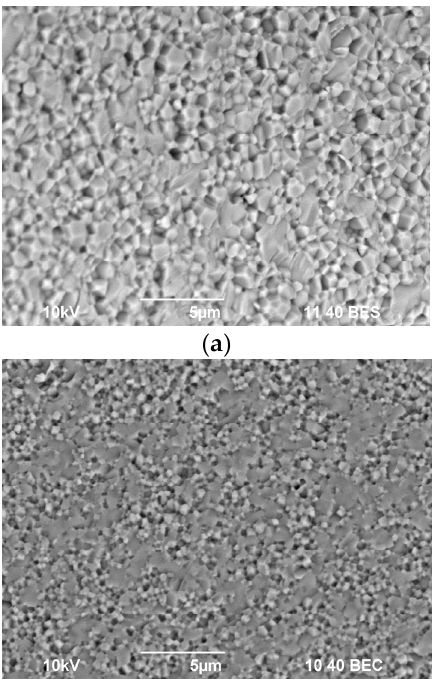
Figure A1. Fracture surfaces of α -Al 2 O 3 samples obtained at Т = 1520 °C at: ( a ) 10 ° С /min, ( b ) 100